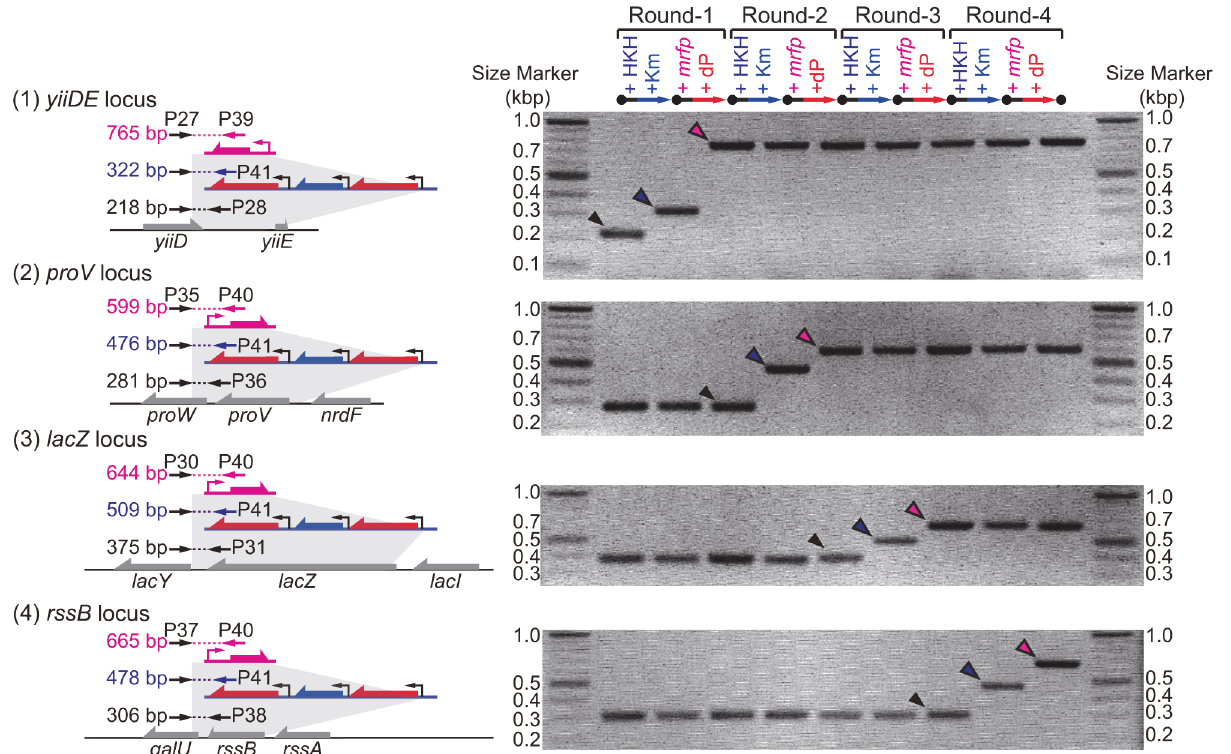
Fig 6. Genotyping of the cell population in each step of mrfp replacement in four different loci. Before, after, and during the 4 successive rounds of gene replacement, all 9 cultures were subjected to competitive PCR analysis using 3 primers annealing to the target, HKH cassette, and p T7 - mrfp cassette sequences. The local sequence, location of the primers and expected size (in bp) of the PCR products are presented for the (1) yiiDE , (2) proV , (3) lacZ , and (4) rssB loci. The sequences of the primers used are shown in S1 Table.